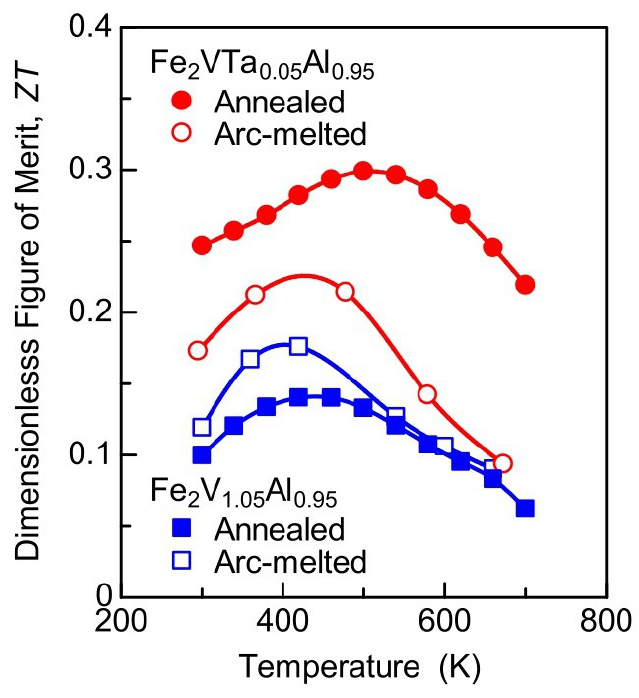
Figure 3. Dimensionless thermoelectric figure of merit as a function of temperature in Fe 2 V 1.05 Al 0.95 and in Fe 2 VAl 0.95 Ta 0.05 . “Annealed” means severely deformed by HPT, followed by annealing. Reproduced from [30], with copyright permission from American Institute of Physics, 2012.